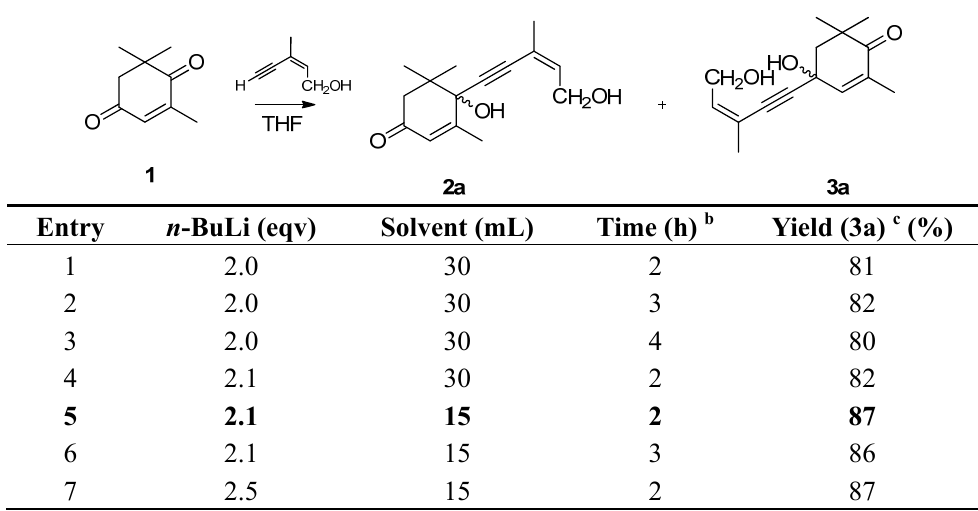
Table 1. Optimization of the reaction conditions a